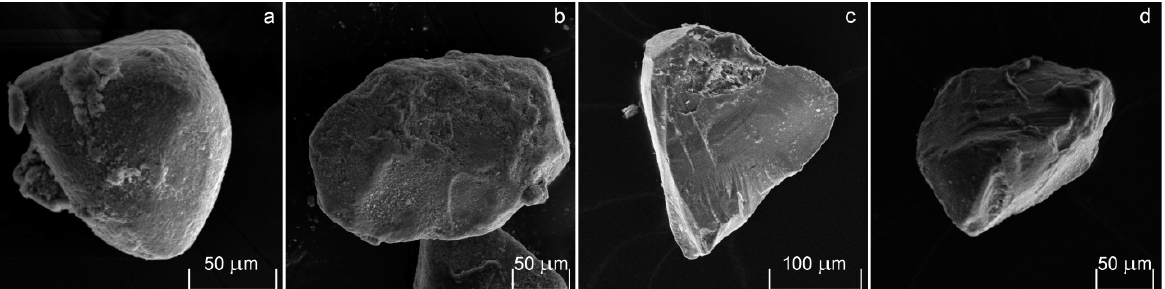
Figure 8. Morphology of chromian spinel grains from the Kolkhoznyi Prud paleoplacer (SE images): ( a )—segment of the octahedron (tritetrahedron-shaped crystal) (group III), ( b )—distorted prolate dodecahedron (group IV), ( c )—crystal fragment (group V), ( d )—xenomorphic grain (group VI).